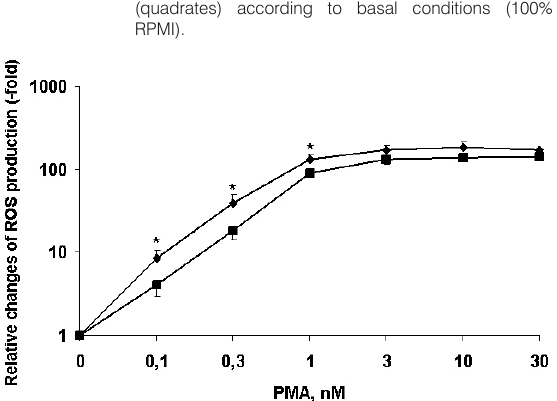
Figure 3. A graph showing a stimulatory effect of S. aureus and opsonized S. aureus bacteria on ROS production in peripheral blood neutrophils of COPD patients (solid line) and HI (dashed line) according to basal conditions (100%